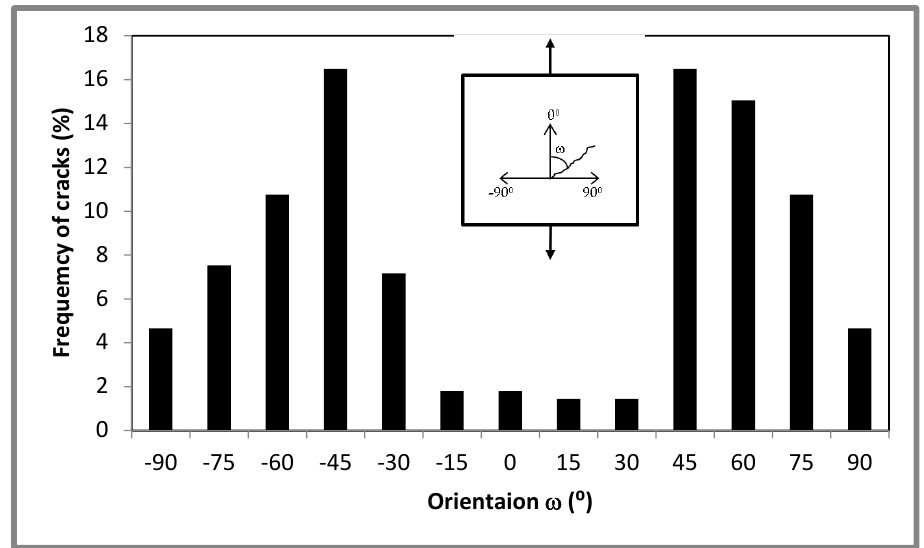
Figure 17. The microcracks and the orientation of the specimen under tension compression loading.